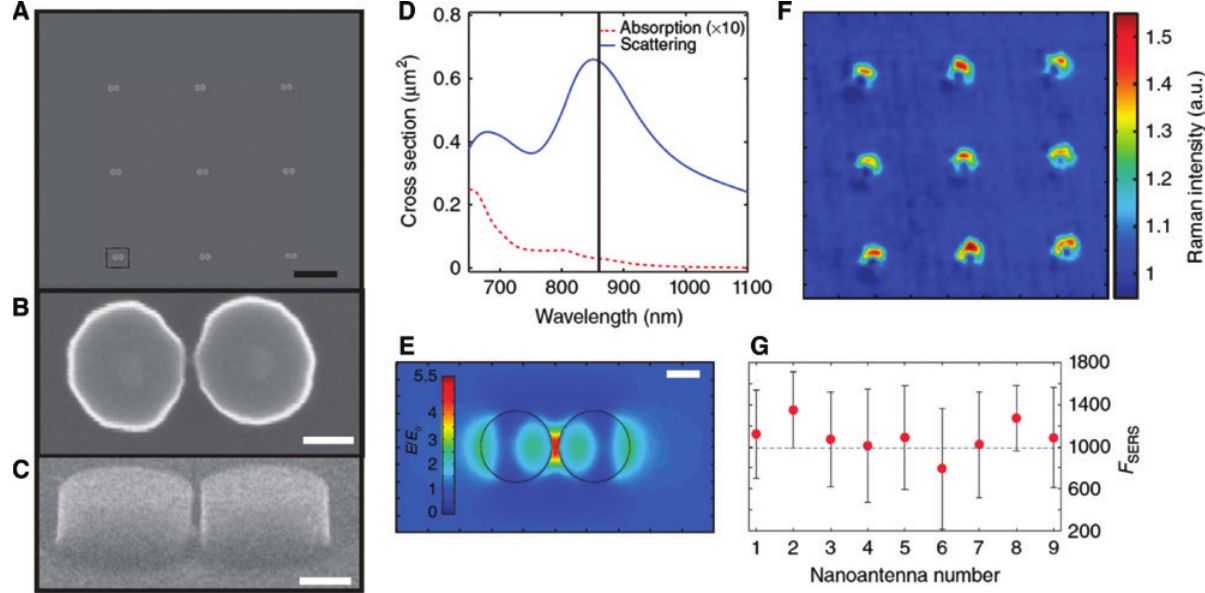
Figure 6: Array of nanostructures fabricated in Si on an SOI substrate. (A) Scanning electron microscopy (SEM) image. Each nanoantenna consists of two identical disks with a diameter of 220 nm, a height of 200 nm, and a 20 nm gap in between. Scale bar, 2 microns. SEM top-view (B) and lateral-view (C) images of a single nanoantenna, indicated in the rectangle in (A). Scale bar, 100 nm. (D) Numerical calculation results showing a scattering resonance at λ = 860 nm (vertical black line) and a low absorption cross-section for the Si dimer in PMMA. Note that the absorption curve is multiplied by a factor of 10. (E) Near- field distribution map for the silicon structure excited at resonance, showing good confinement of the electric field in the gap. Note that the maximum enhancement value is 5.5. Scale bar, 100 nm. (F) Experimental 2D normalized Raman map, showing enhanced signal coming from the molecules close to the nanoantennas. (G) SERS enhancement factors obtained for each individual nanoantenna shown in (F) after volume normalization. The error bars show half the difference between the minimum and the maximum Raman intensity value in each nanoantenna. The dashed line corresponds to ( E / E ) 4 from (E). Adapted from max 0